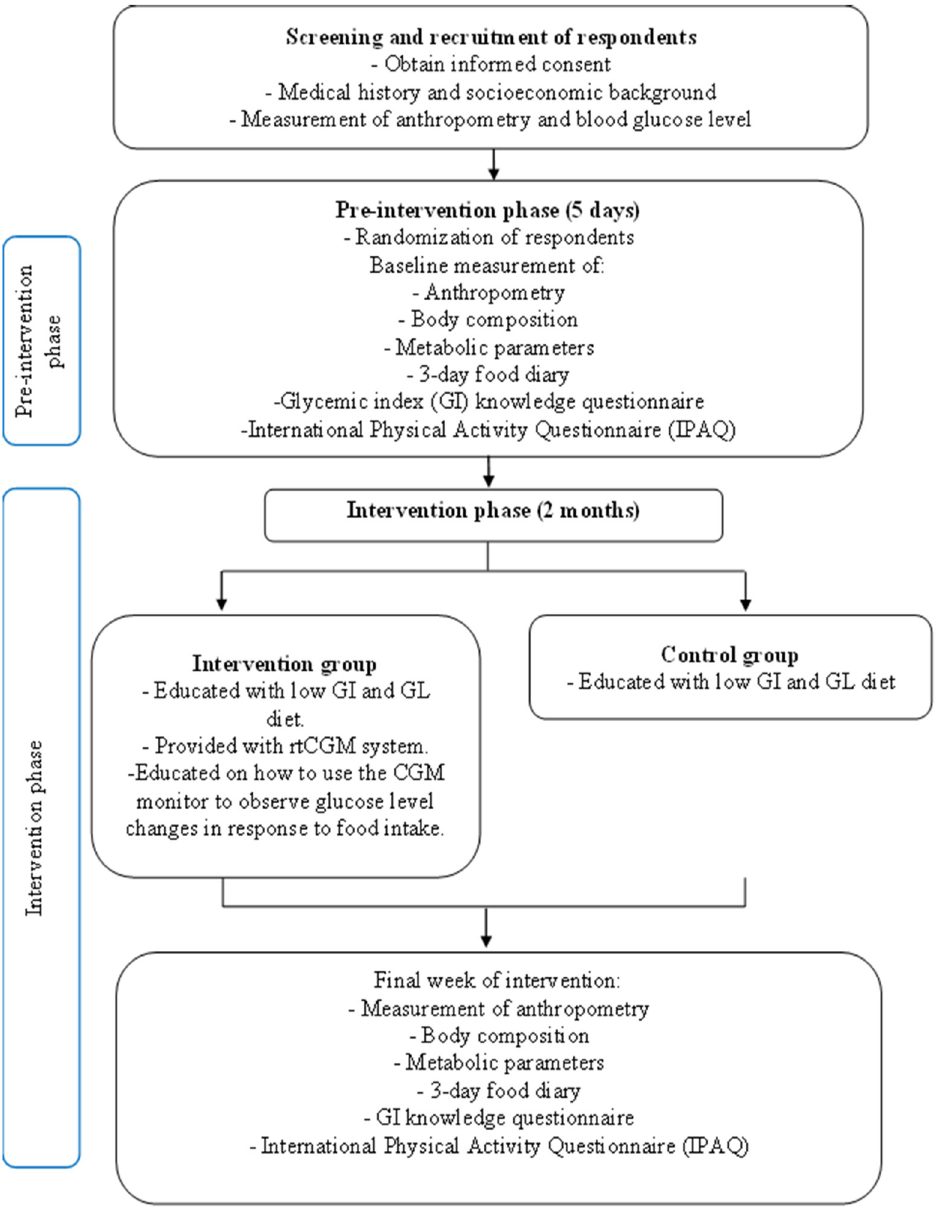
Figure 2. Intervention flow diagram.